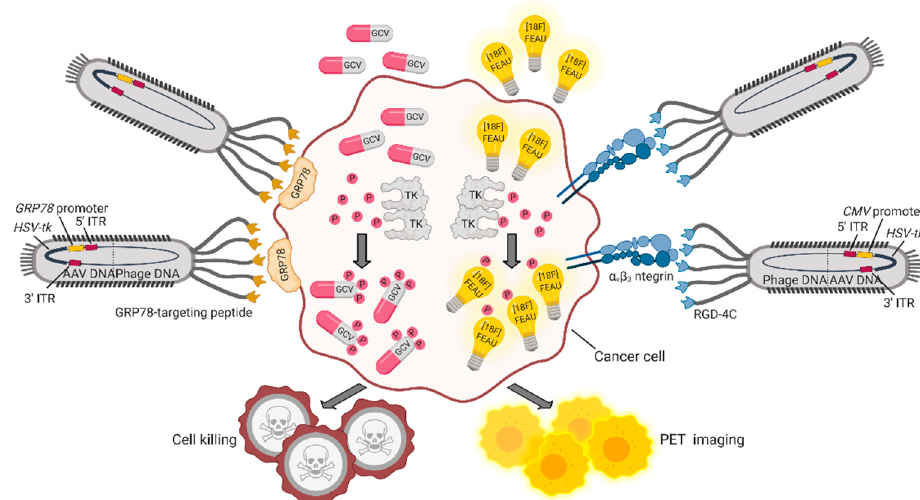
Figure 2. Theranostic applications of the hybrid AAVP vector. AAPVs can be ligand-targeted to a tumor-specific cell surface molecule such as α v β 3 integrin [53] or GRP78 [59], followed by internalization of DNA and production of AAVP-coded proteins. The HSVtk transgene codes for TK, an enzyme that adds phosphate groups to thymidine analogues and converts (i) the prodrug GCV in the cytotoxic drug GCV triphosphate and (ii) [ 18 F]FEAU in [ 18 F]FEAU phosphate, which is retained intracellularly, allowing detection by PET imaging. Figure created with BioRender.com.